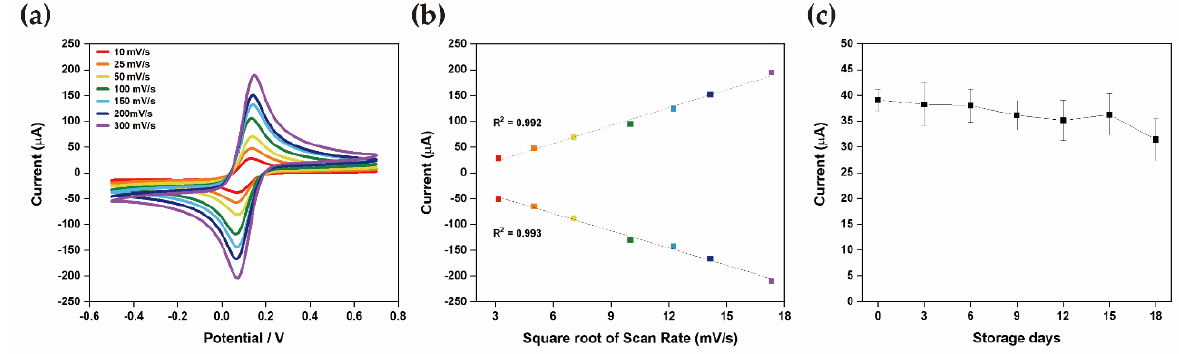
Figure 2. ( a ) Cyclic voltammetry (CV) response test for stability with 10 to 300 mV/s scan rates. ( b ) The oxidation and reduction current peaks from graph ( a ). ( c ) The long−term storage ability test in humid conditions at 4 °C over 18 days. Measurements were taken every 3 days and calculated as the mean value of peak current from 1.0 ng/mL leptin in tripli-cate.